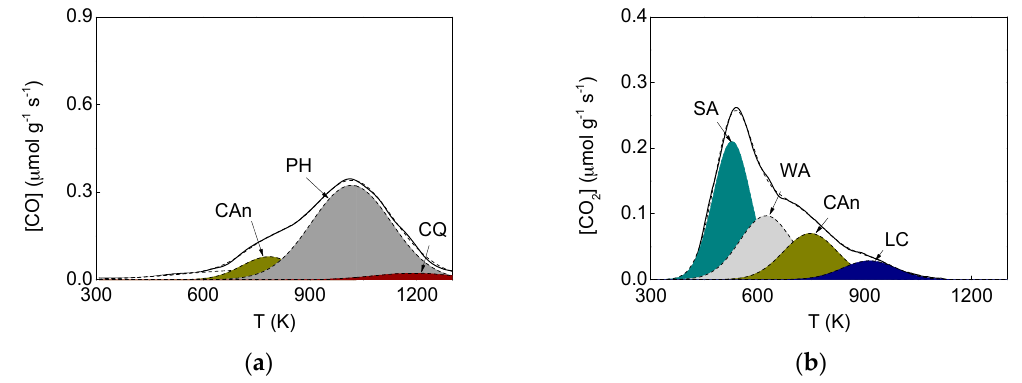
Figure 2. Deconvolution of temperature programmed desorption (TPD) profiles of commercial CNTs treated with a 7 M HNO 3 solution at boiling temperature: groups released as ( a ) CO and ( b ) CO 2 (PH—phenols; CAn—carboxylic anhydrides; CQ—carbonyl/quinones; LC—lactones; CAc—carboxylic acids; SA—strong acidic CAc; WA—weakly acidic CA) (adapted from [32]).